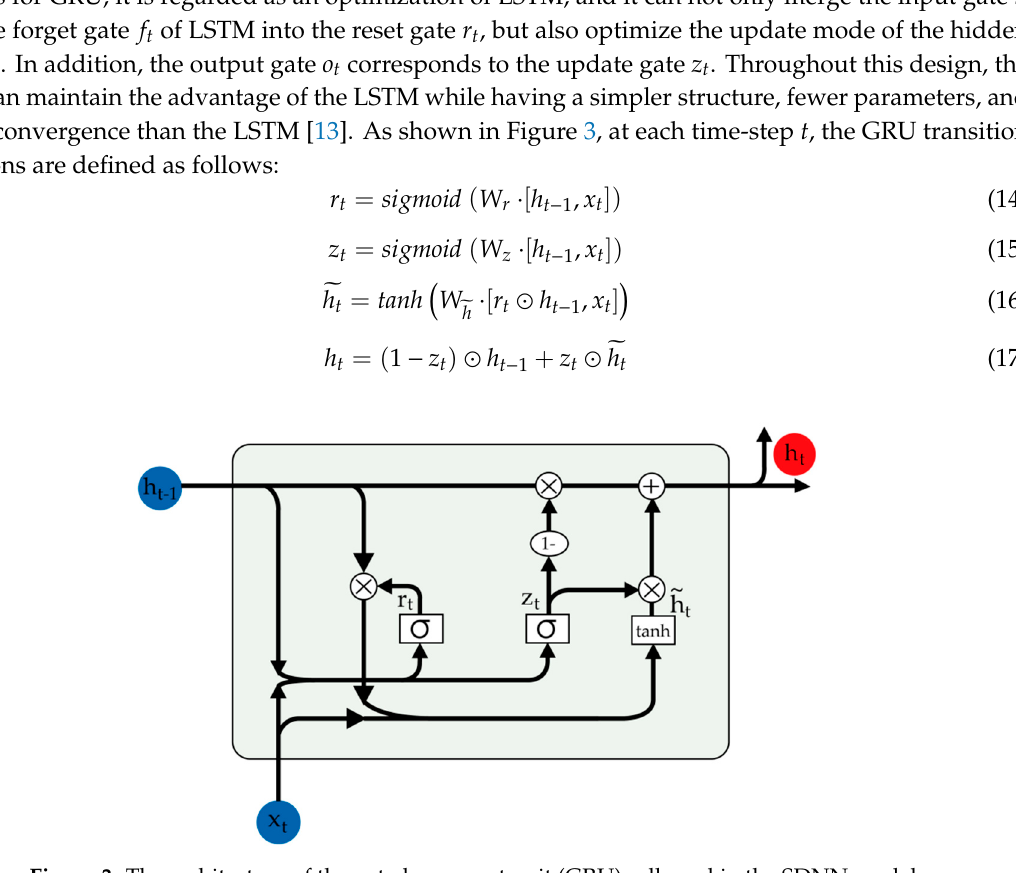
Figure 3. The architecture of the gated recurrent unit (GRU) cell used in the SDNN model.